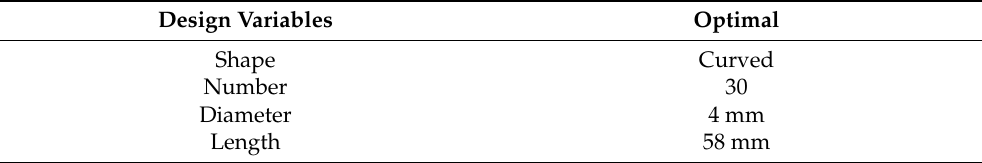
Table 8. Optimal values of design variables.